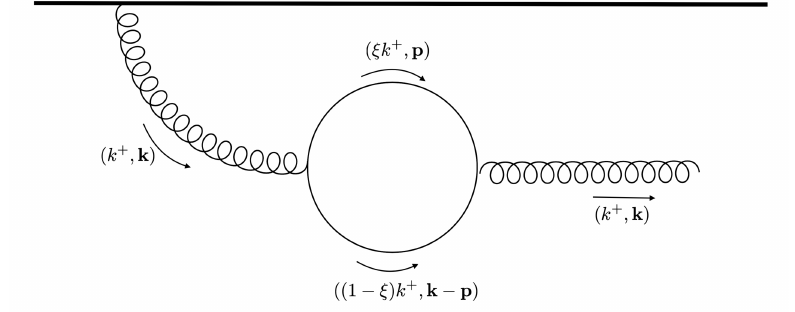
Figure 3 . Quark loop correction for the single gluon emission diagram; ξ is the defined as ξ ≡ p + /k + . The horizontal thick line is the valence